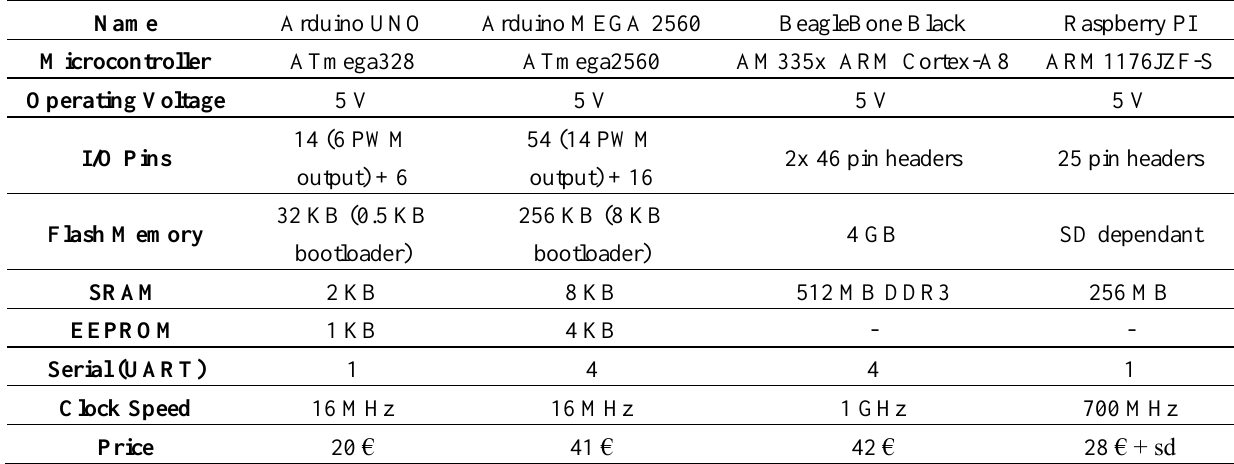
Table 1. Technical characteristics of the sensor boards evaluated.